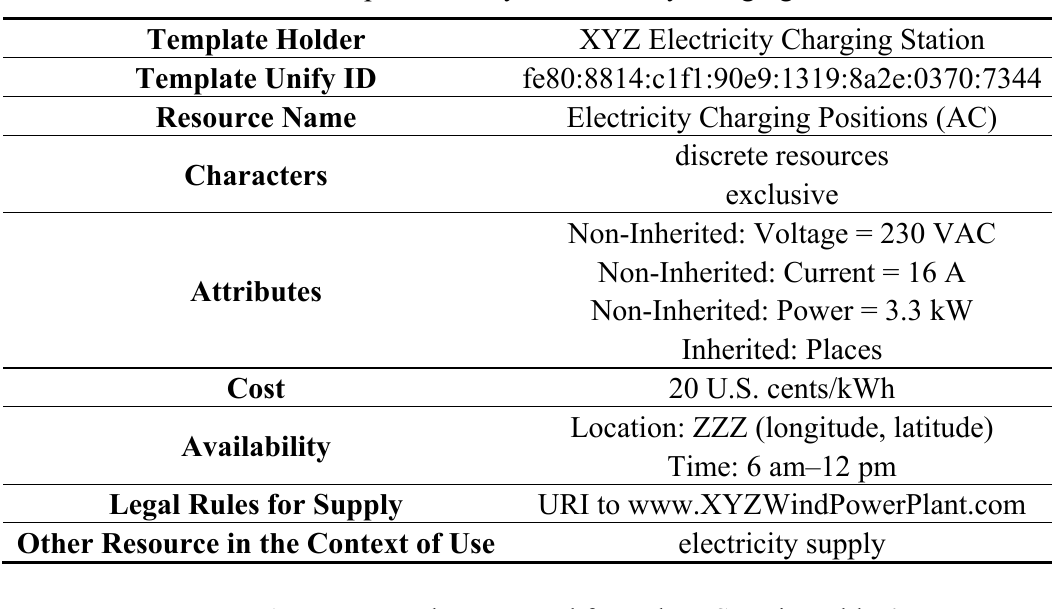
Table 5. An RIN sample generated from the RSDT in Table 4.